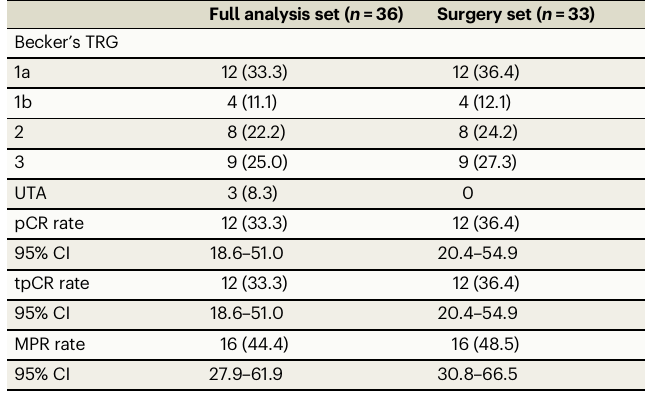
Table 1 | Baseline characteristics of full analysis set ( N = 36)